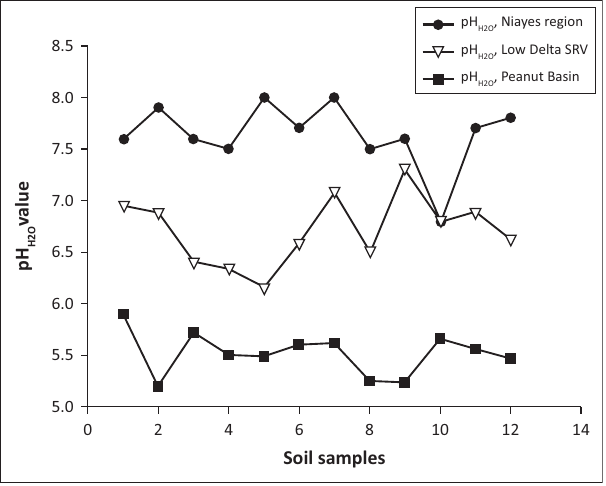
values in the Niayes region, the Peanut H2O